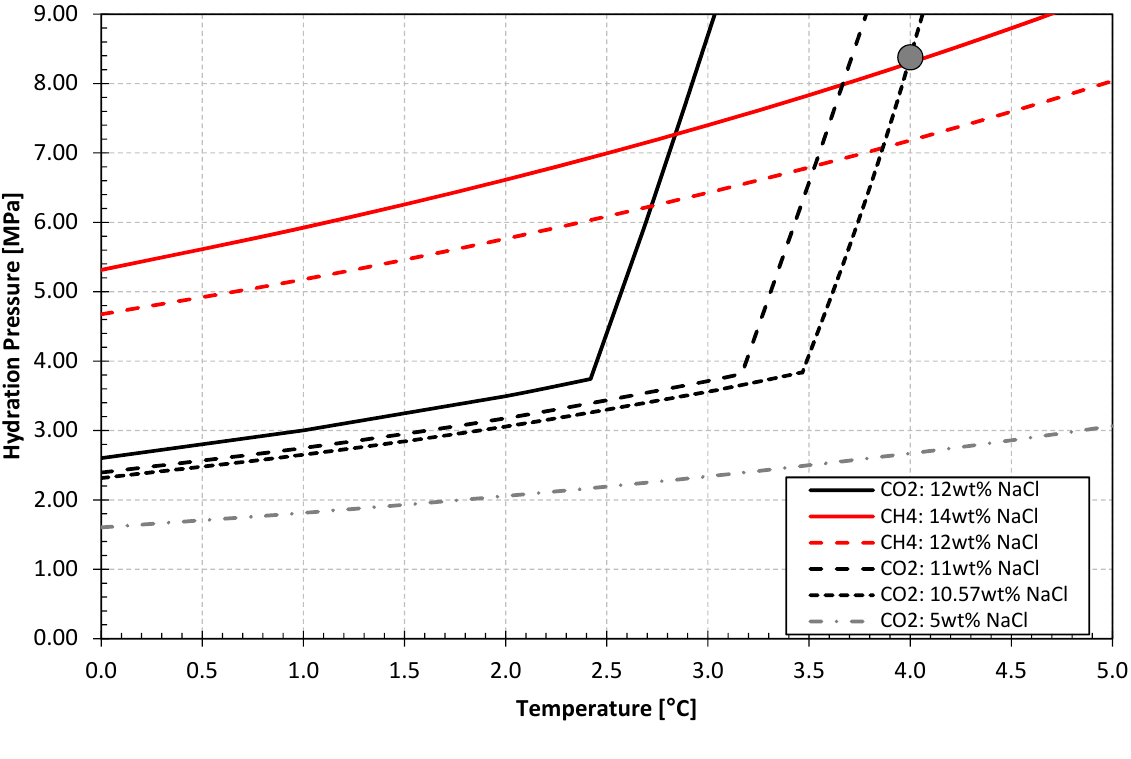
Figure 8. Hydrate three-phase equilibrium lines at varying salinities for CH 4 and CO 2 guest molecules. CH 4 , represented by the red lines, is less susceptible to variations in ion concentration than CO 2 . Gas hydrate formation at the experimental conditions (marked by the grey circle) will be inhibited at 14.9 wt% NaCl for CH 4 hydrates and 10.6 wt% NaCl for CO 2